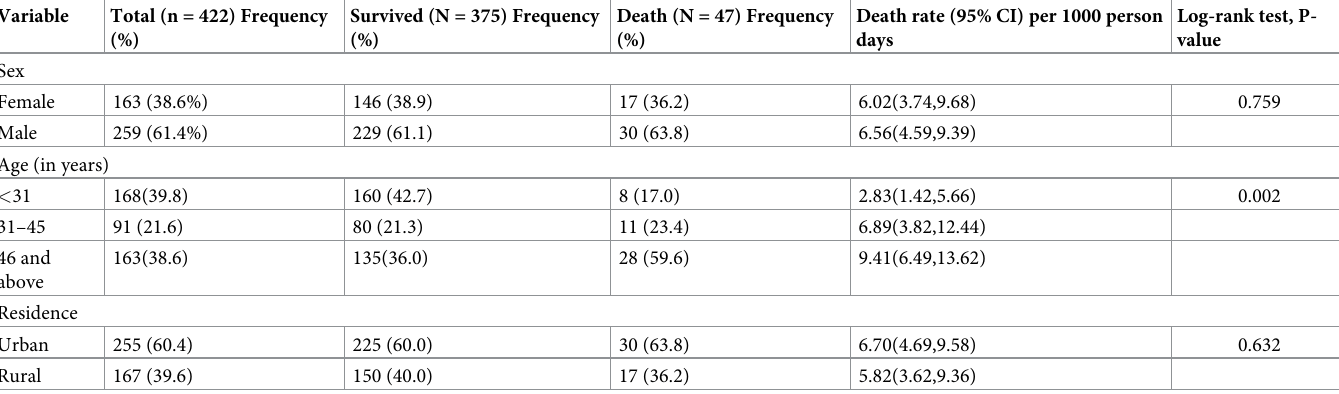
Table 1. Sociodemographic characteristics and treatment outcome status of hospitalized patients with COVID-19 to Bokoji Hospital treatment centre,